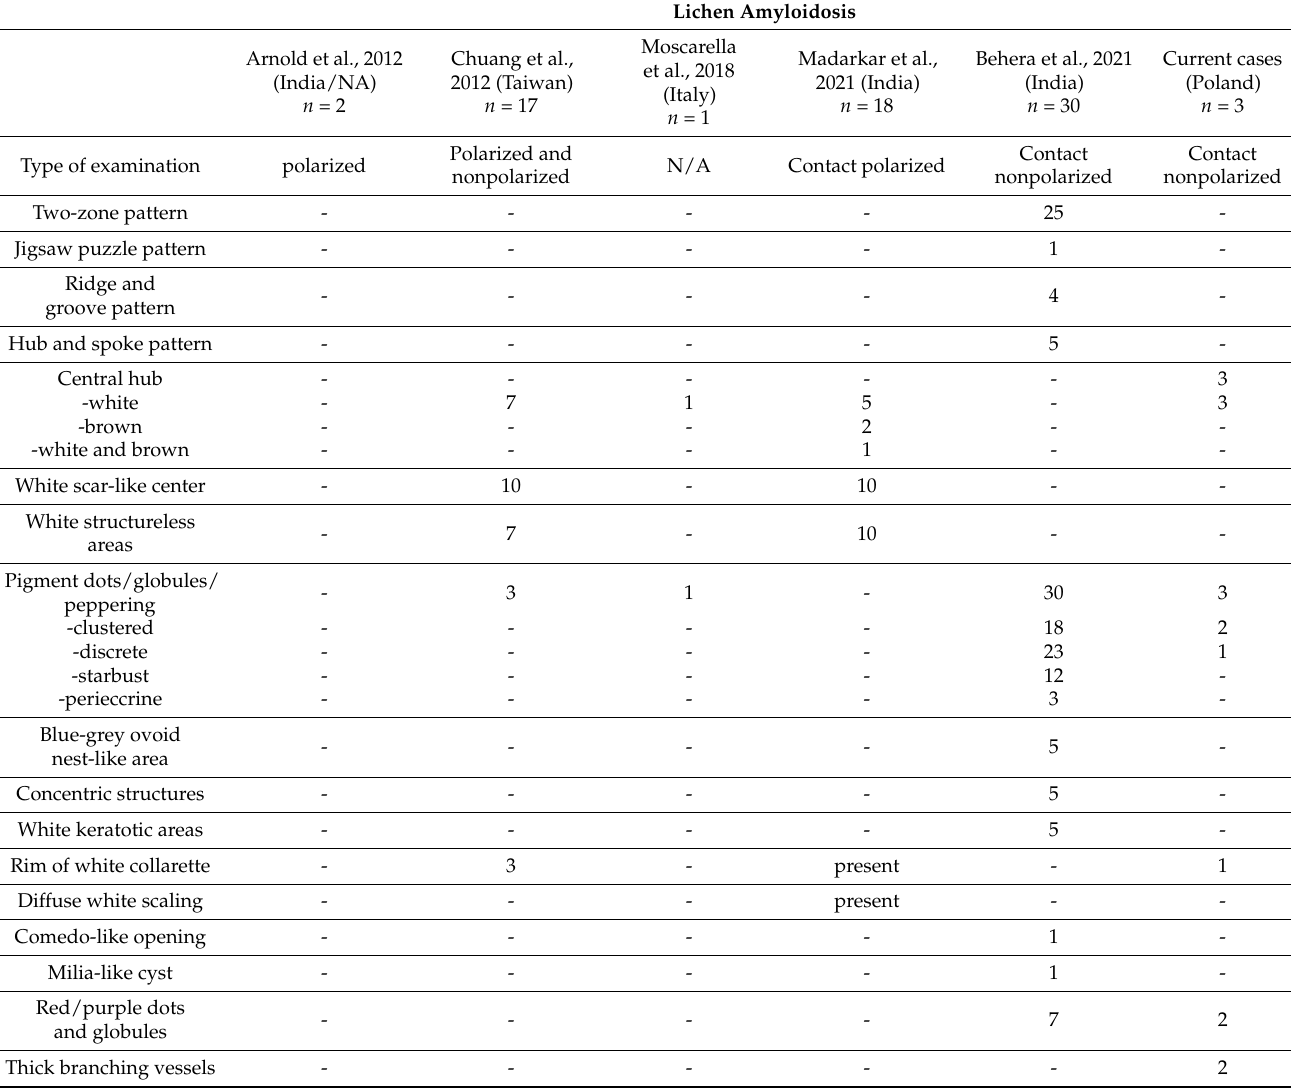
Table 1. A summary of studies describing the dermoscopic features of primary cutaneous amyloidosis